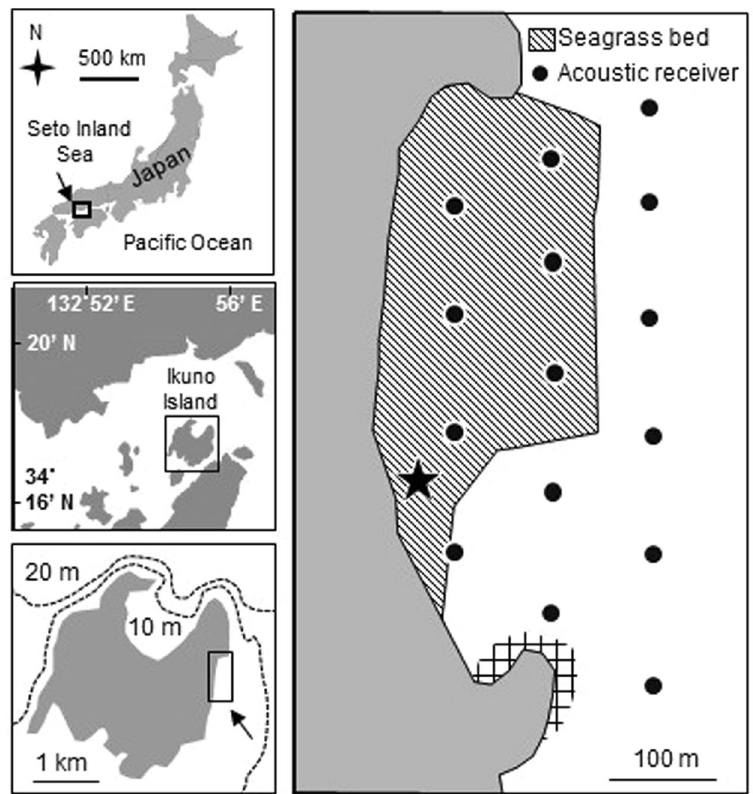
Figure 2. Map showing the survey area off Ikuno Island, the central Seto Inland Sea, southwestern Japan. Seasonal fish sampling was conducted in the seagrass bed during daytime and nighttime in October 2009, January, April, and July 2010. Depth contours are represented by dotted lines in the bottom-left panel. Acoustic telemetry was used to detect visits by predatory fishes in the same area. The star indicates the location where tagged fishes were released for acoustic telemetry. The rocky bottom area in the southern part of the surveyed area is indicated with a meshed shading. The maps were created by the first author using Microsoft PowerPoint 2010